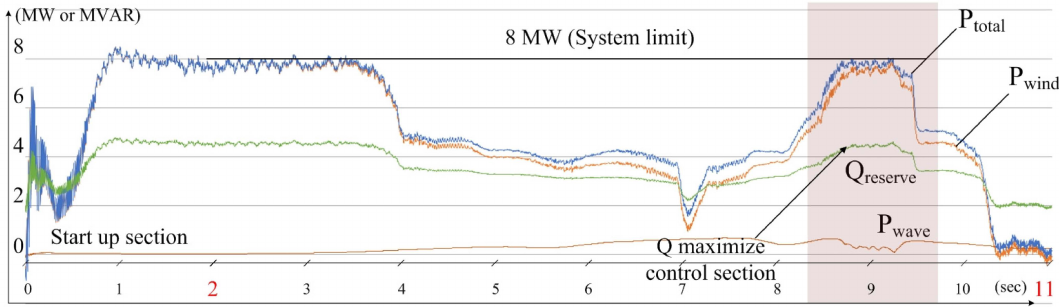
Figure 10. Output power and available reactive power curve of the HGS with proposed control method (Case 1).